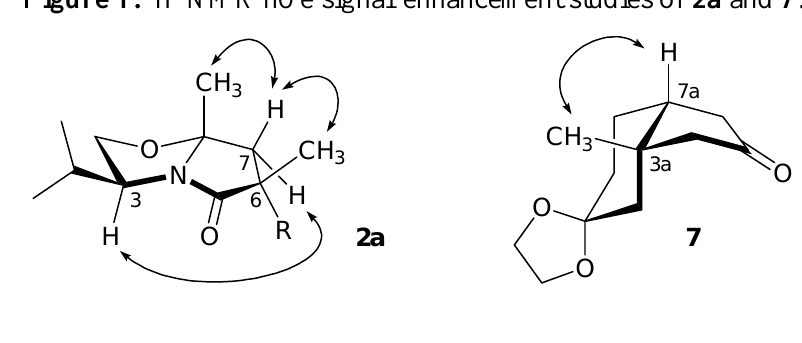
Figure 1. 1 H-NMR nOe signal-enhancement studies of 2a and 7